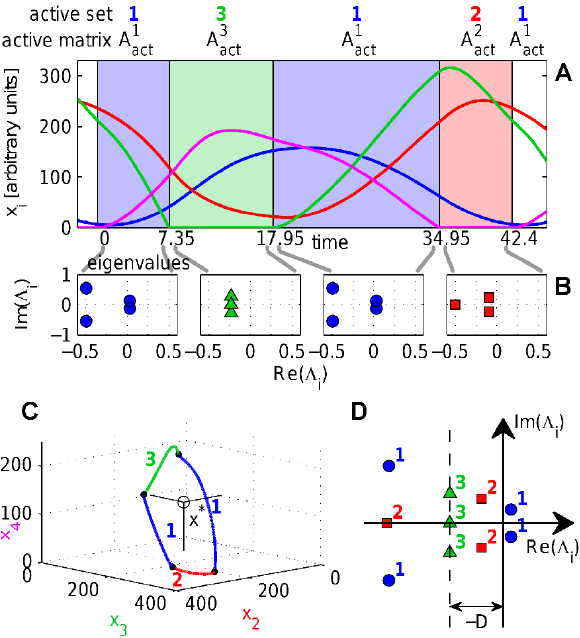
Figure 1. Periodic dynamics and active sets. Sequentially linear system with decay rate D i ~ 0 : 23 and the fixed point x (cid:2) agents i simulated with time-increment dt ~ 0 : 05 . Periodic time-series organized into a sequence of four domains with three different active sets. For each time-domain the associated spectrum of eigenvalues for the active sets is shown in (b). In (c) a 3 d Poincare map of the limit cycle is plotted together with the projection of x (cid:2) in the center. The domains are marked with bold numbers and switching events with dots. (d) The eigenvalue spectra of the different subsystems are plotted in the imaginary plane. The shift of the spectrum along the real axis depending on the decay rate D is indicated.